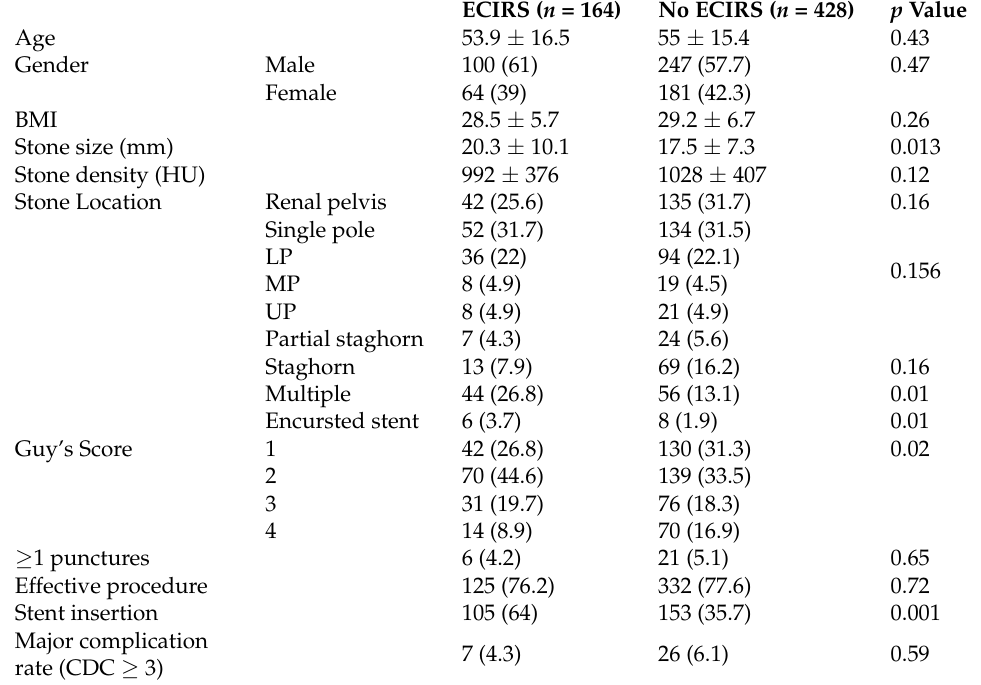
Table 3. Risk factors and outcomes for Endoscopic Combined Intrarenal Surgery